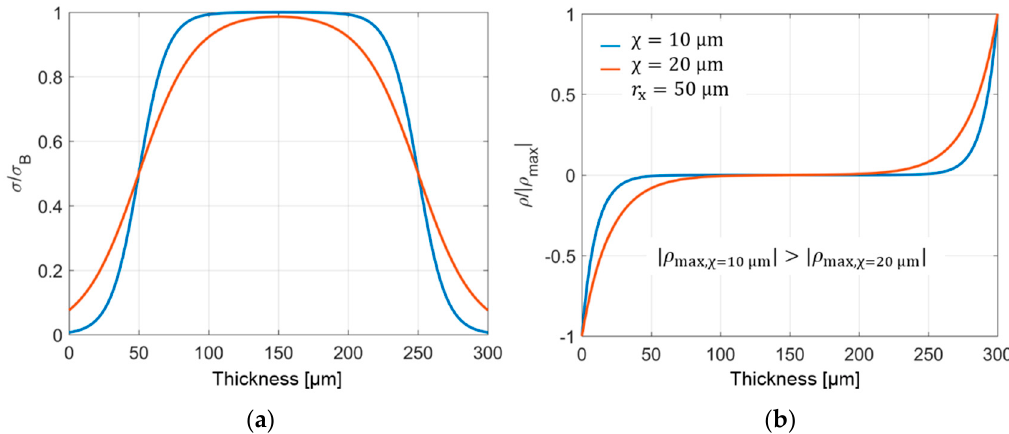
Figure 2. Influence of distance constant χ on conductivity gradient and resulting space charge distribution ρ . ( a ) normalized conductivity σ / σ B ; ( b ) normalized stationary space charge distribution [10].